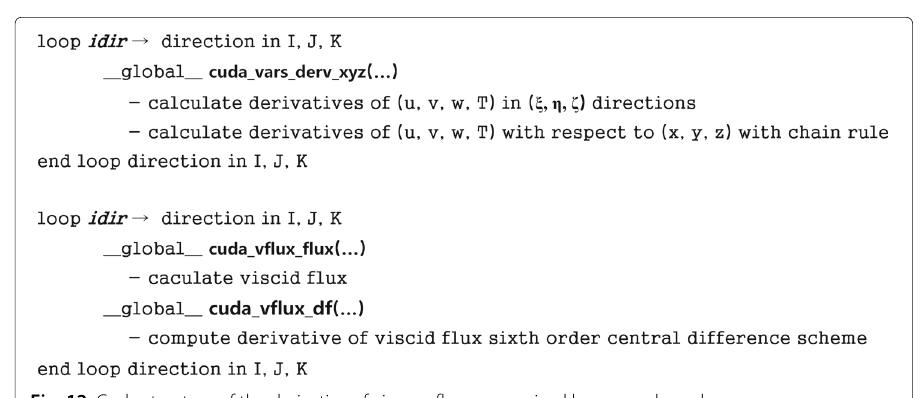
Fig. 12 Code structure of the derivative of viscous flux summarized by a pseudo